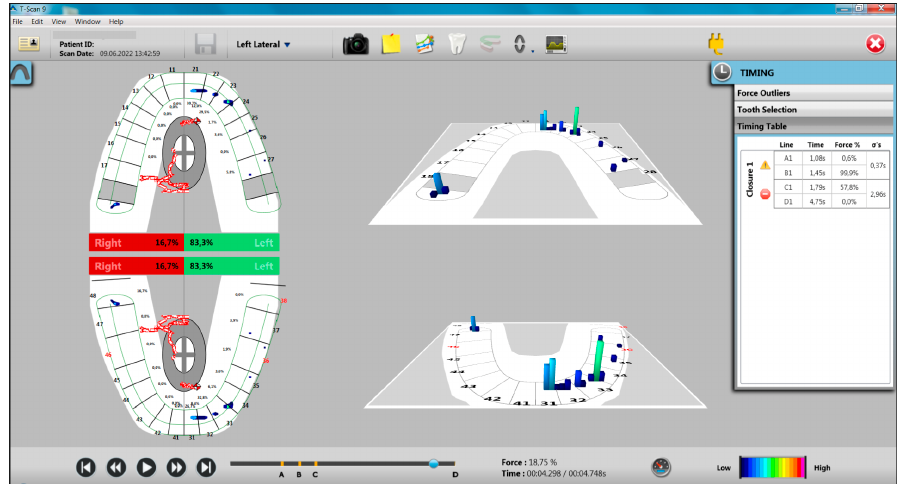
Figure 4. Aspects of T-Scan recording of left laterotrusion movement to a participant with bruxism. Note the antero-lateral group guidance and a non-working interference.